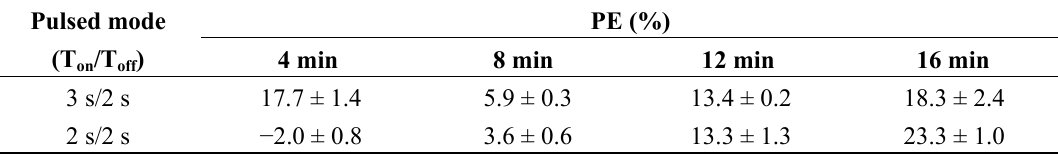
Table 3. The PE values of 3 s/2 s pulsed type and 2 s/2 s pulsed type at different time (4–16